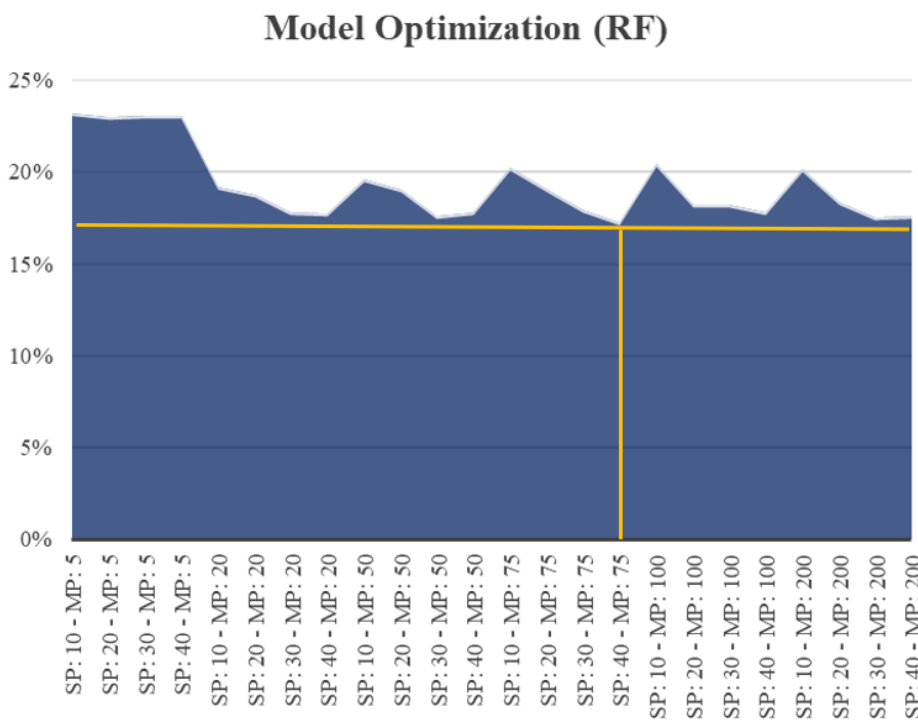
Figure 11. Model optimization for the RF model for total PVs.